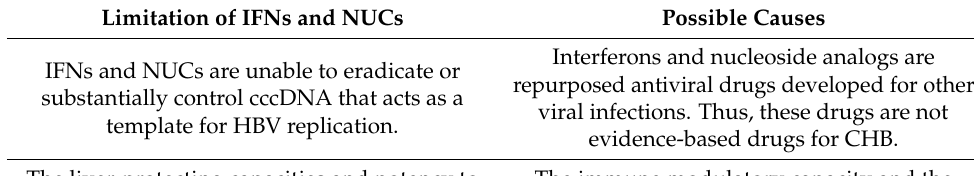
Table 1. Limitations of commercially available antiviral drugs and possible underlying